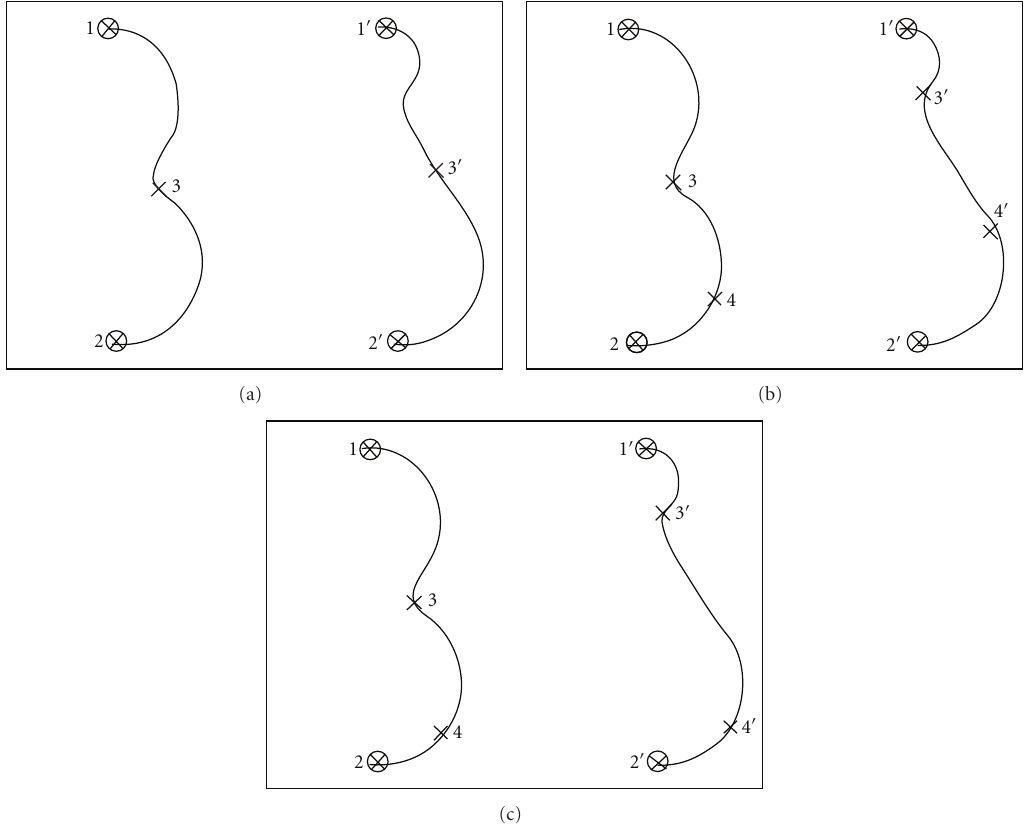
Figure 1: An example of the landmark generation and optimization. The left and right columns show the source and target curves, respectively. (a) The first two landmarks (1 and 2, circled X) and their homologues (1 (cid:2) and 2 (cid:2) , circled X) are fixed at the two ends of the corresponding source and target curves. The 3th landmark (3) is placed in the middle of the longest segment of the source curve, and its homologue (3 (cid:2) ) is placed on the target curve. (b) The landmarks (3 and 3 (cid:2) ) are then relaxed from their initial locations and slid to match each other; and the 4th landmark (4) is placed in the middle of the longest segment of the source curve, and its homologue (4 (cid:2) ) is placed on the target curve. (c) The 4th landmarks (4 and 4 (cid:2) ) are then relaxed from their initial locations to match each